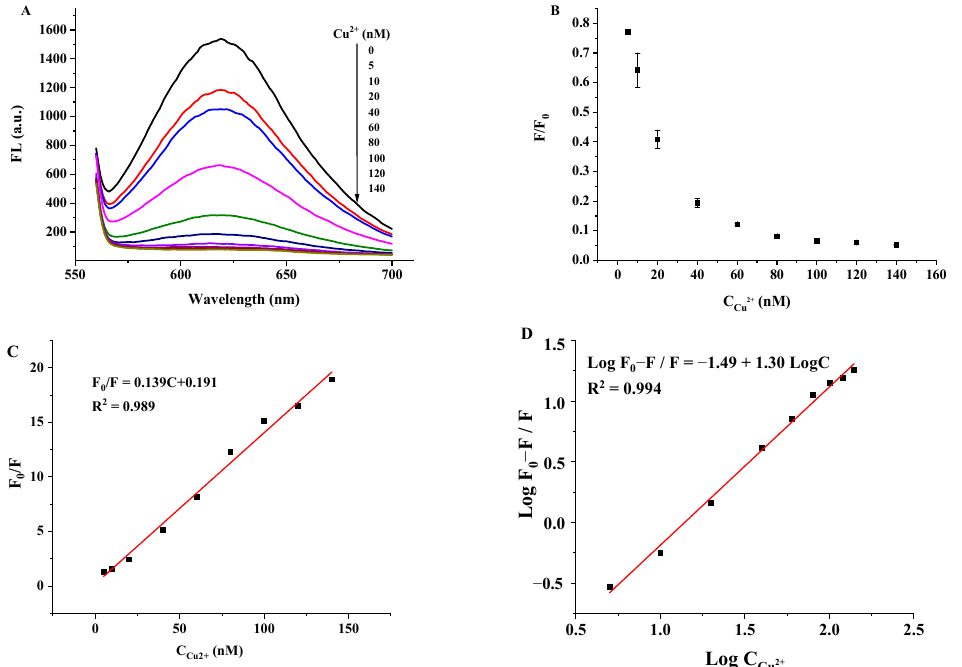
Figure 8. ( A ) The fluorescence quenching effect of DNA2-Ag NCs after adding Cu 2+ (0 nM~140 nM). ( B ) The relationships between the F/F 0 and different concentrations of Cu 2+ . ( C ) The Stern–Volmer plots of DNA2-AgNCs with Cu 2+ F 0 and F are the fluorescence intensities of the DNA2-Ag NCs in the absence and presence of Cu 2+ . ( D ) Computation of the binding constant (K) of each binding site and the number of binding sites of DNA-AgNCs (n).